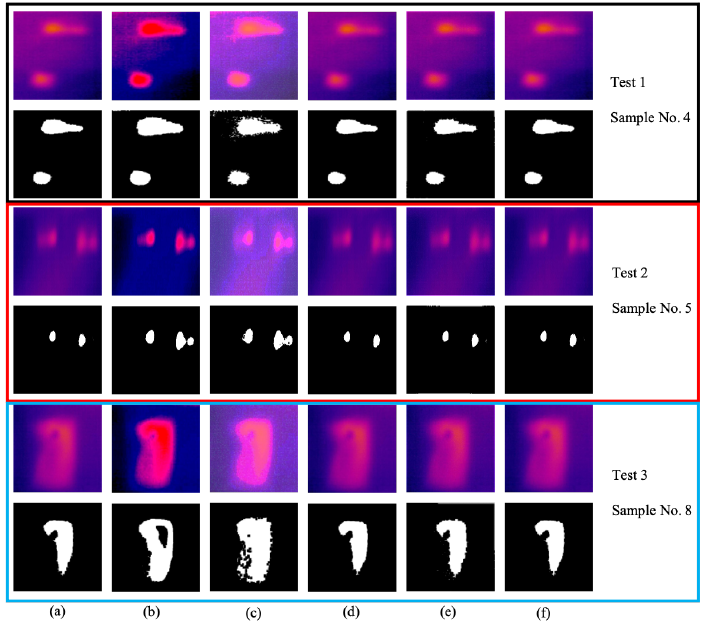
Figure 4. The results of preprocessing and binarized images: ( a ) Raw image; ( b ) Contrast adjustment; ( c ) Histogram equalization; ( d ) Mean filter; ( e ) Log filter; ( f ) Gaussian filter. Three samples were selected in order to show the results from different preprocessing methods. The first two rows of images resulted from sample No. 4, the median two rows resulted from sample No. 5, and the last two rows of images are results from sample No. 8. The defects in Sample No. 4 and No. 5 have the same depth and number but different areas, while the defect in sample No. 8 has a deep depth and a larger